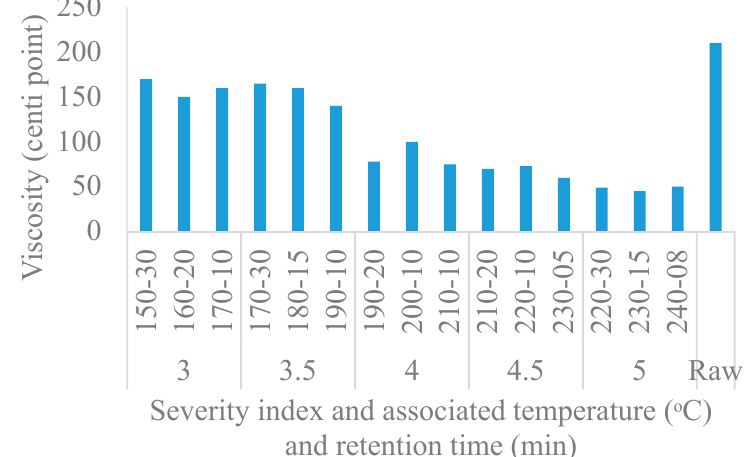
Figure 3. Viscosity of raw and hydrothermally pretreated samples after HTP.